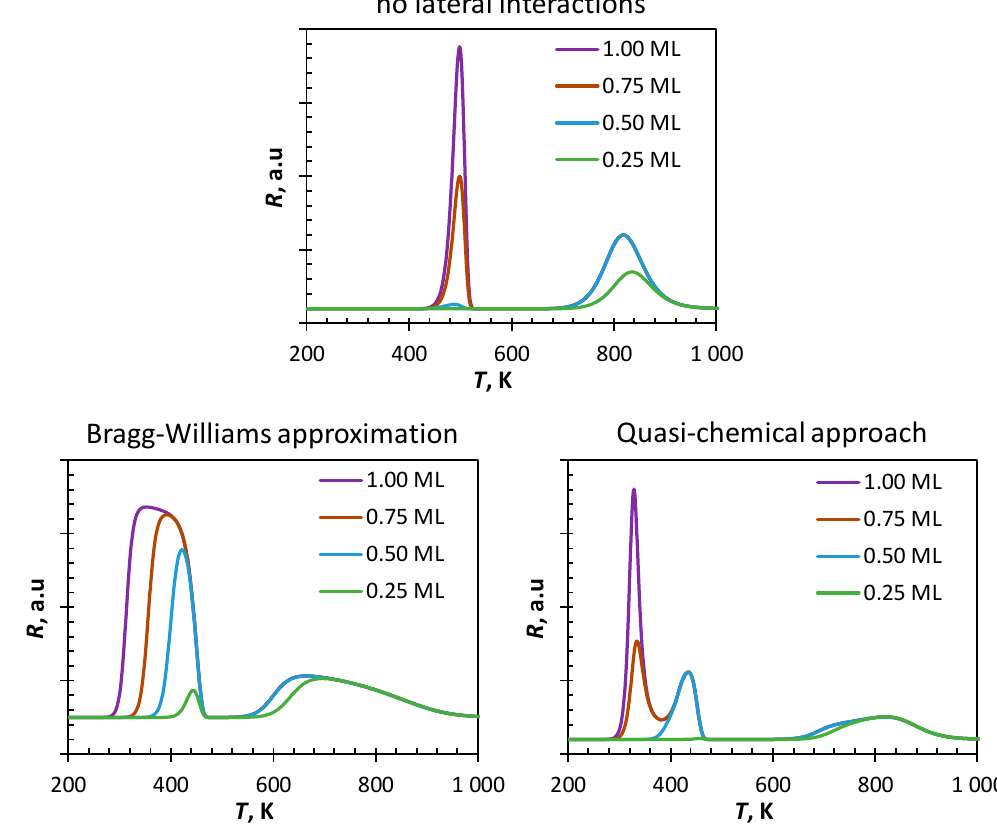
− 1 ) obtained using mean-field